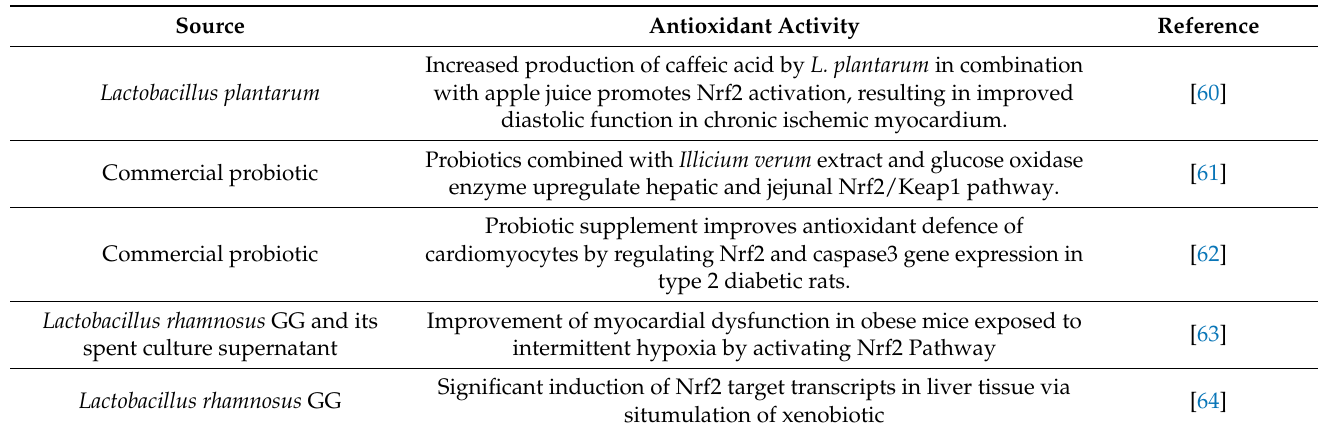
Table 2. Nrf2 activating abilities of probiotic